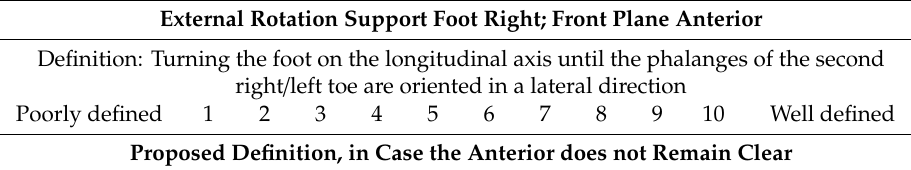
Table 1. Example questionnaire for expert